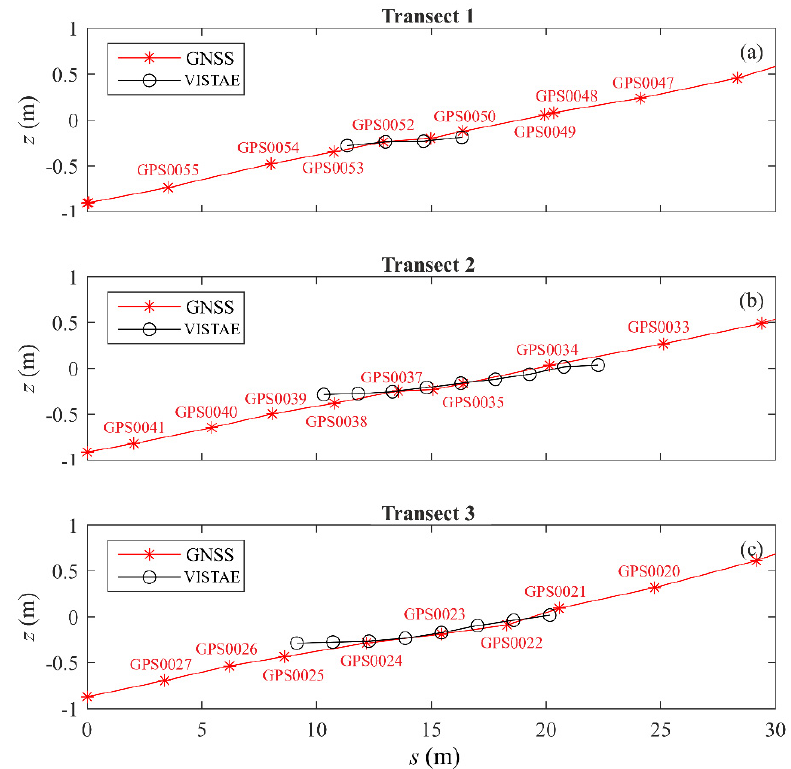
Figure 12. Comparison between transects measured by the GNSS (red lines) and extrapolated by the low-cost camera (VISTAE, black lines). The red tags indicate the same GPS points measured in Figure 11a.